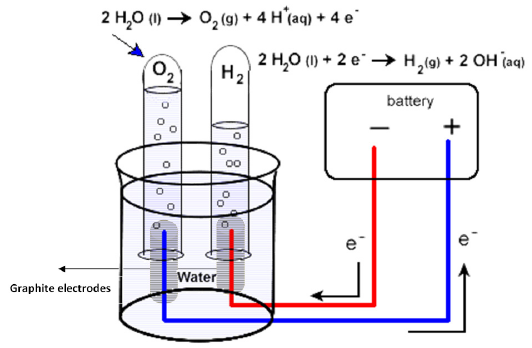
Figure 1. A schematic diagram represents the electrolytic production of hydrogen gas.